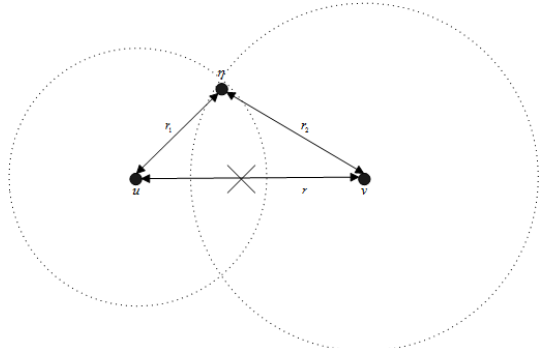
Figure 3. Transmission range adjustment.